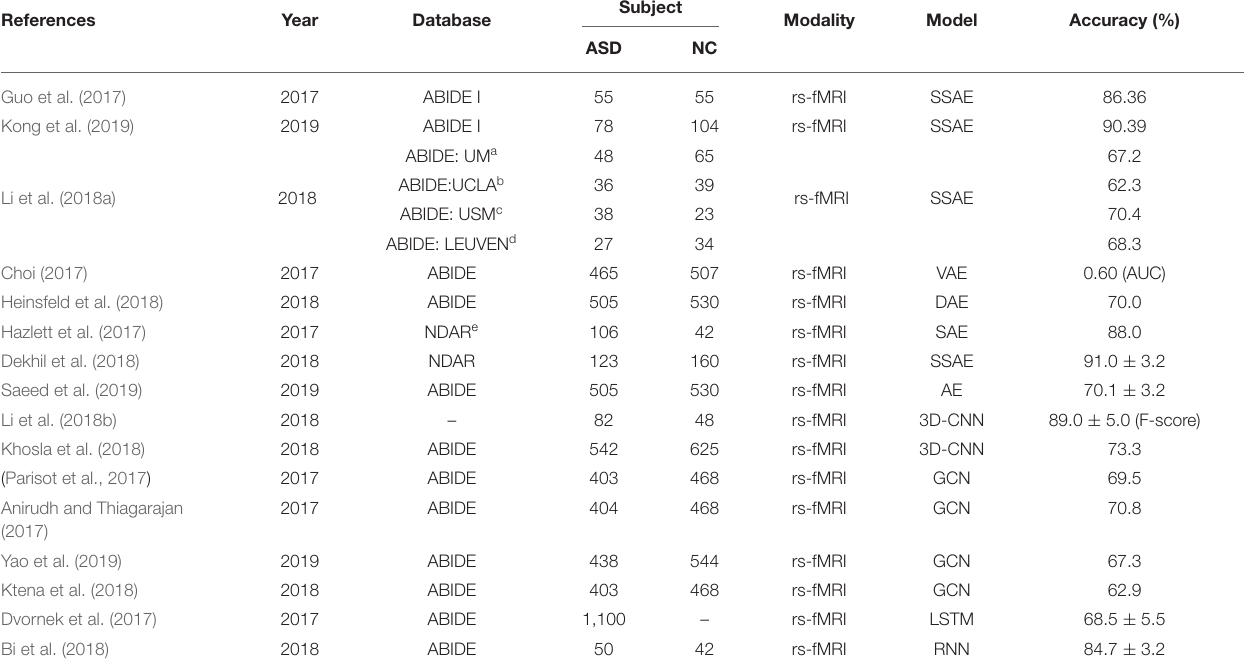
TABLE 6 | Overview of papers using deep learning techniques for ASD